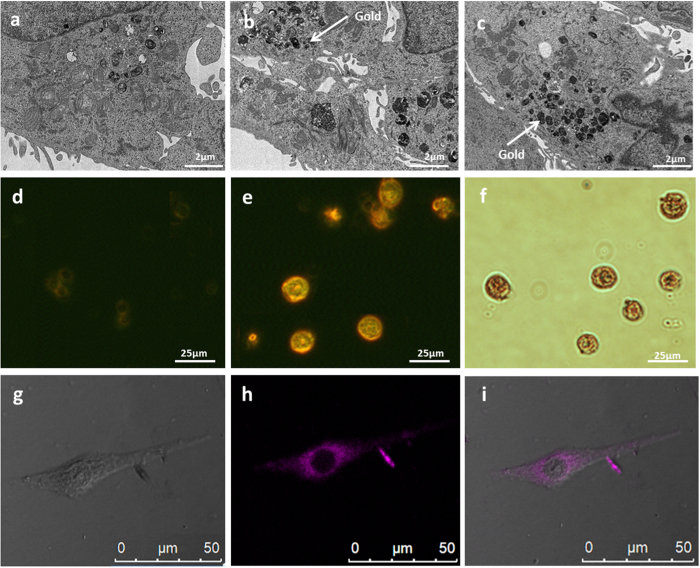
Efficiency of cell labeling with GNPs; microscopy images.(a–c) TEM imaging of a cancer cell. (a) cancer cell without GNPs. (b,c) cancer cell loaded with GNPs, the white arrow points an accumulation of well-defined GNPs inside endosomes. (d,e) dark field microscopy of stem cells (d) without GNPs. (e) loaded with GNPs (Yellow-red). (f) Bright field microscopy of stem cells loaded with GNPs. (g–i) representative confocal images of cancer cell after 30 min incubation with fluorescent-coated glucose-GNPs complex. (g) bright field image of the cell. (h) fluorescent-coated glucose-GNPs (purple). (i) Bright field combined images. Images were taken at the midsection of the cell. Sections were imaged using Leica TCS SP5 with Acousto-Optical Beam Splitter microscope.